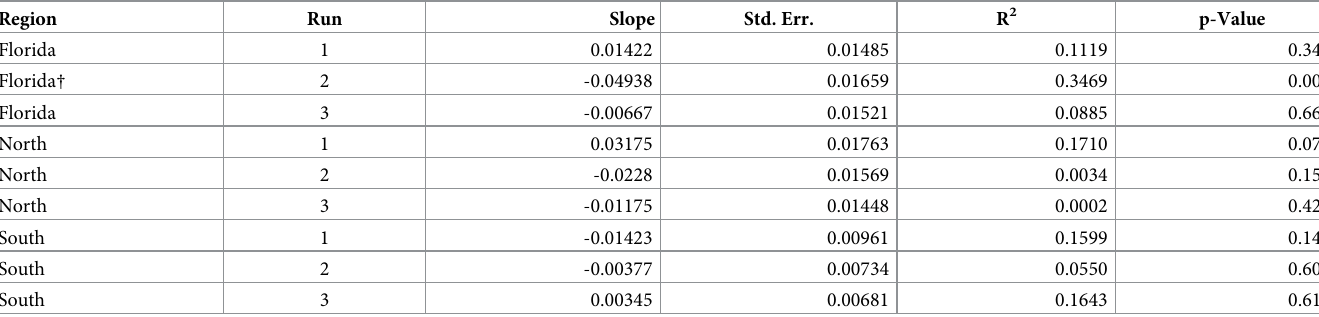
Table 7. Region-run Average Call Index (ACI) linear models.